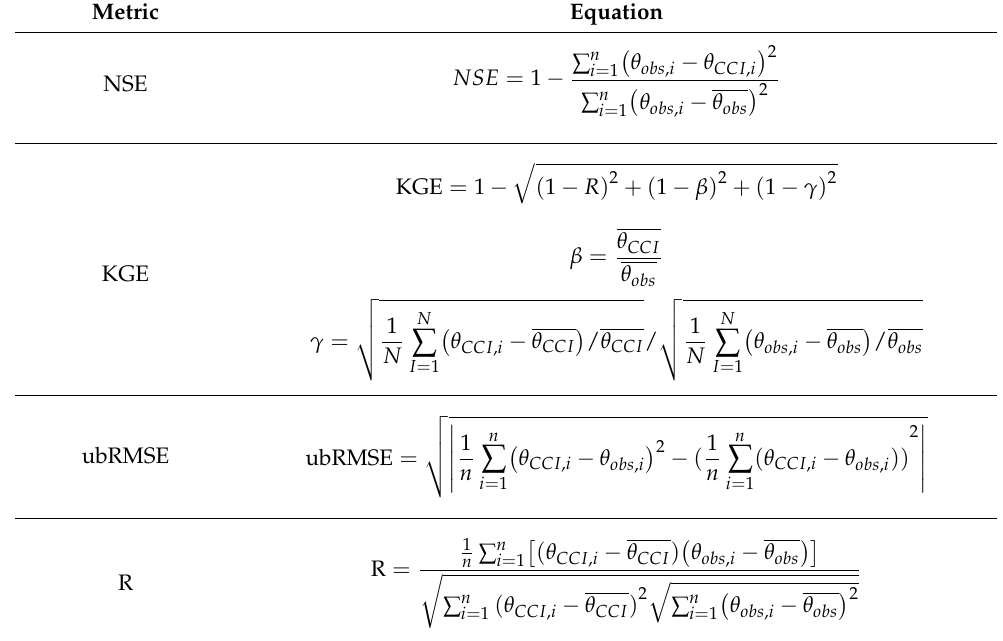
Table 2. Statistical metrics to assess the accuracy of SM data. θ obs , i and θ CCI , i denote the in-situ observed and CCI-C SM contents (SMC) in the i day, respectively; θ obs and θ CCI denote the average value of the observed and CCI-C SMC, respectively; n is the size of records (Rahman and Shang, 2020).